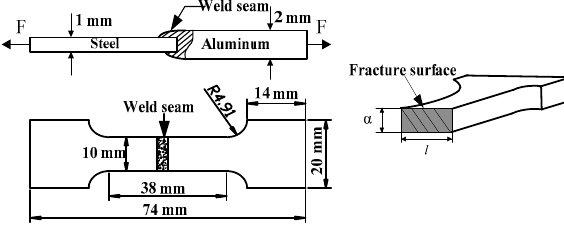
Figure 2. The geometry of tensile specimens and fracture surface.